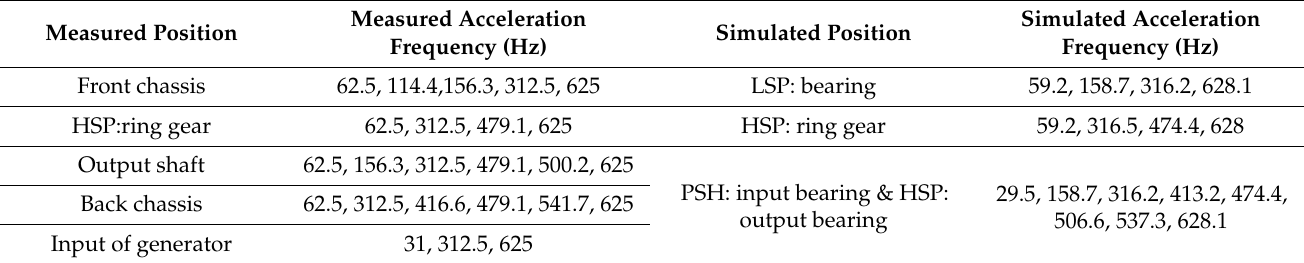
Table 8. Eigen-frequencies comparison of the entire system.